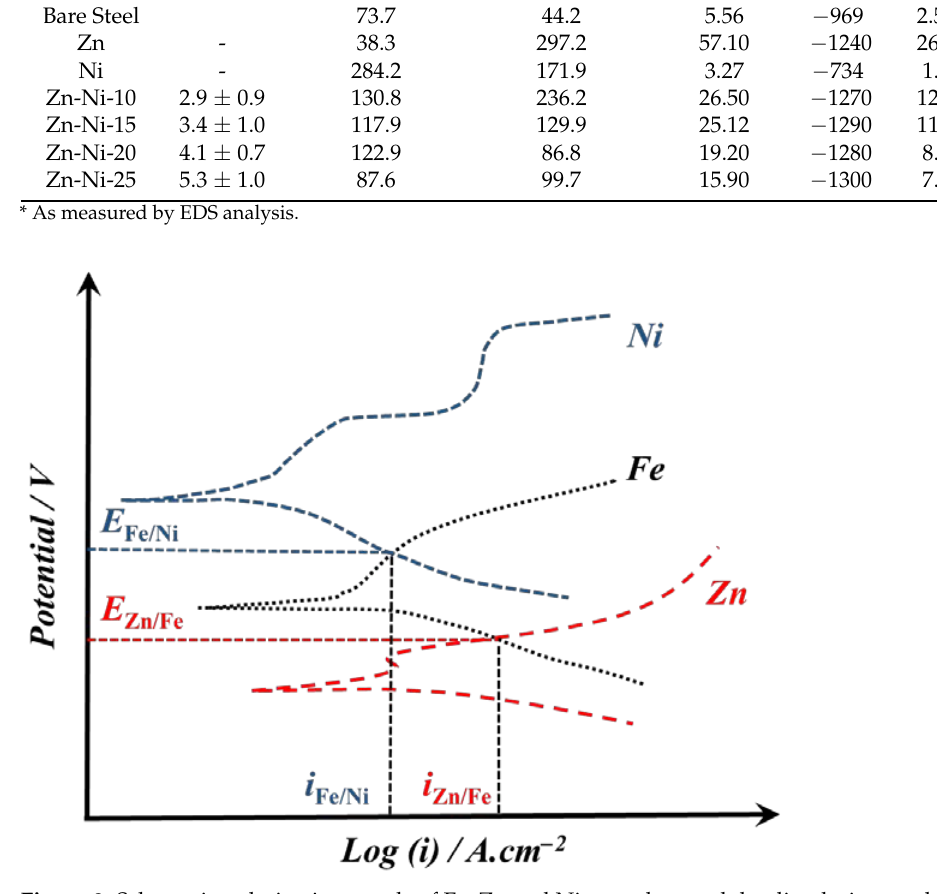
Figure 8. Schematic polarization trends of Fe, Zn and Ni to understand the dissolution tendency of metallic coatings on the steel surface.